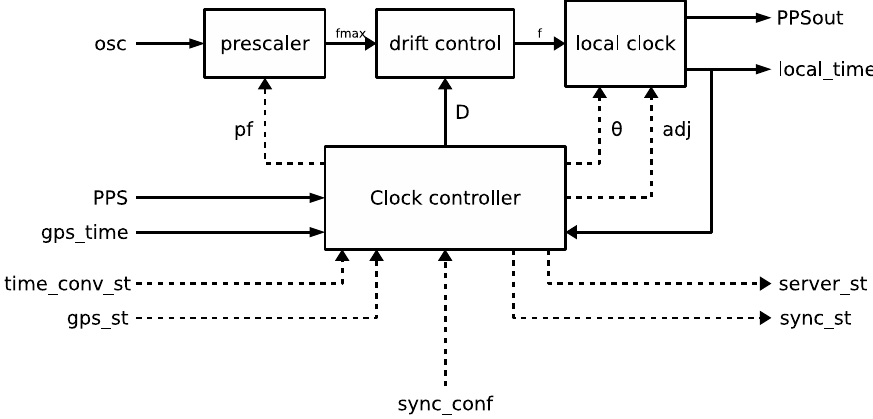
Figure 9. Synchronization module including the proposed hardware clock model and clock